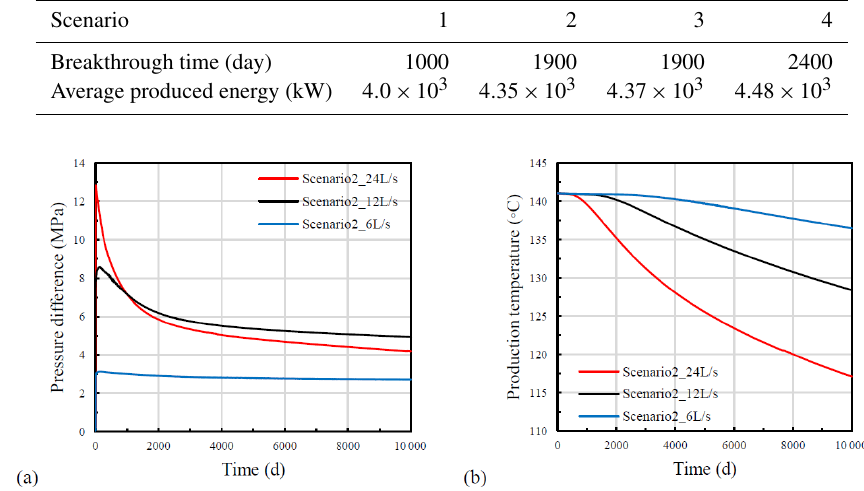
Figure 11. Evolution of (a) pressure difference and (b) temperature at the production well for different flow rates (Scenario 2).